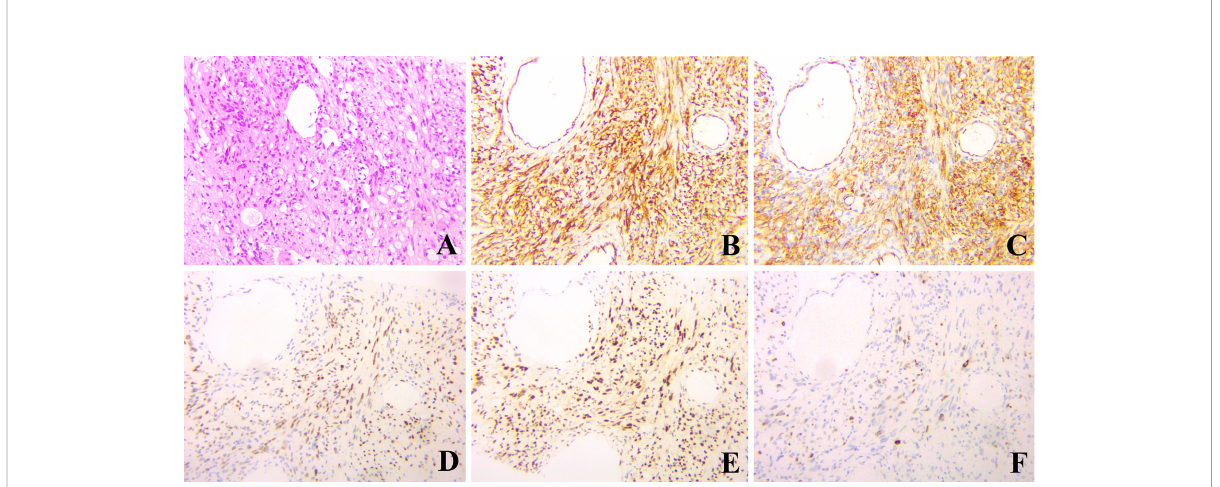
FIGURE 3 Hematoxylin & eosin and immunohistochemical staining of the liver biopsy, which showed spindle-shaped tumor cells and epithelioid tumor cells ( A , hematoxylin & eosin, ×200), and positive for CD 31, CD34, ERG and Fli-1 ( B-E , respectively, ×200). The index rate of Ki-67 was 20% ( F ,